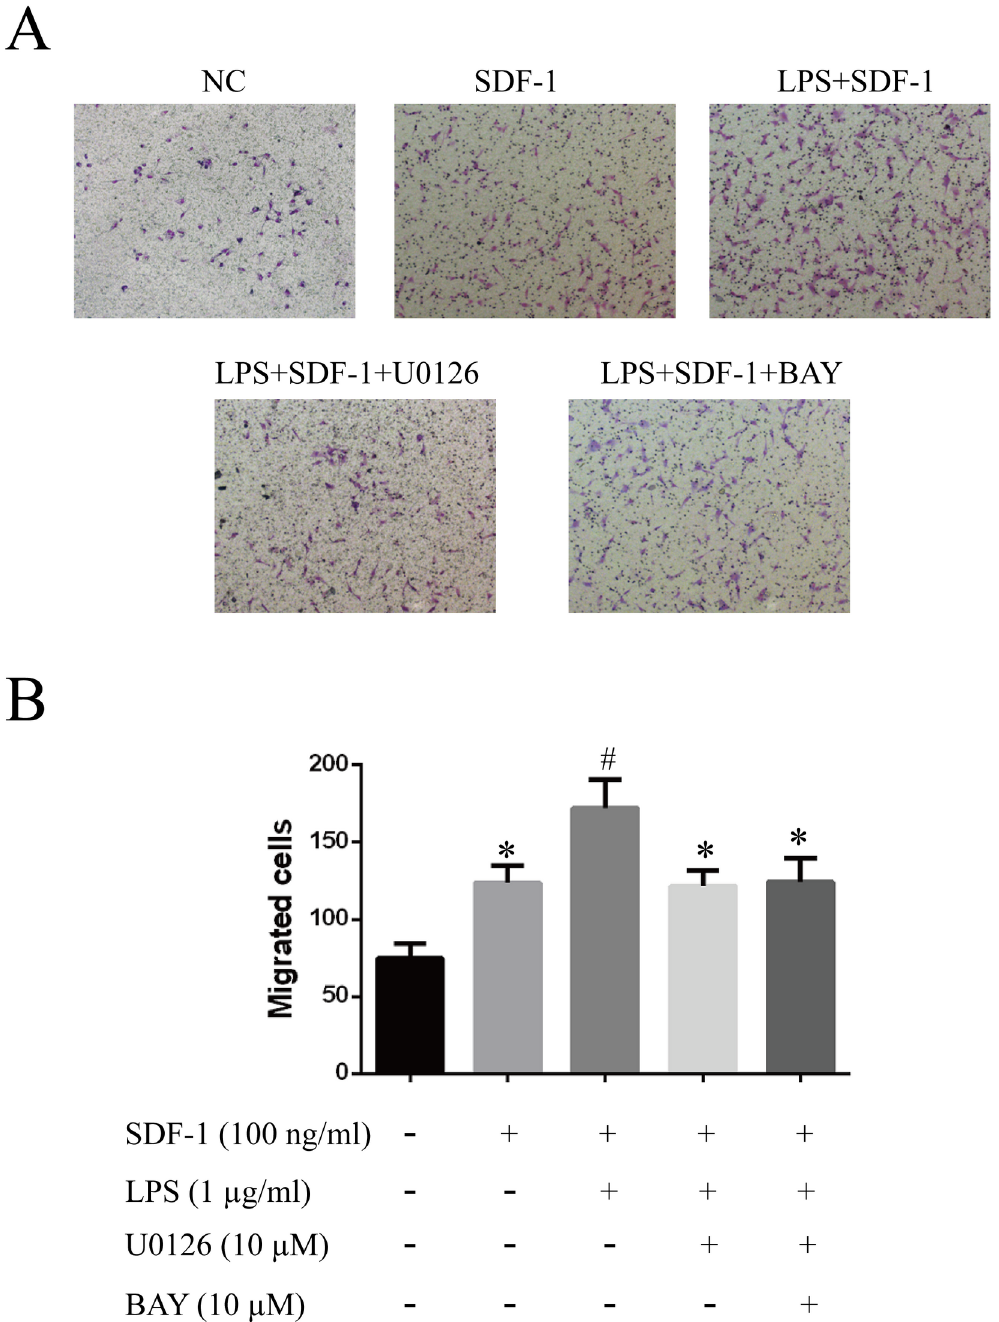
Fig 5. Effects of LPS on the SDF-1-induced migration of RF/6A cells. The migratory activity of RF/6A cells after different treatments was estimated based on the number of cells that migrated through the filter inserts. Representative images of cell migration are given: untreated ( A ); SDF-1 (100 ng/ml) alone in the lower chamber ( B ); LPS (1 μ g/ml) pretreatment plus SDF-1 (100 ng/ml) in the lower chamber ( C ); combined LPS and U0126 pretreatment plus SDF-1 in the lower chamber ( D ); combined LPS and BAY 11 – 7082 pretreatment plus SDF-1 in the lower chamber ( E ). ( F ) Quantitative analysis of the number of migrated cells, expressed as the mean ± SD. Statistical significance determined using one-way ANOVA with * P < 0.05, ** P <